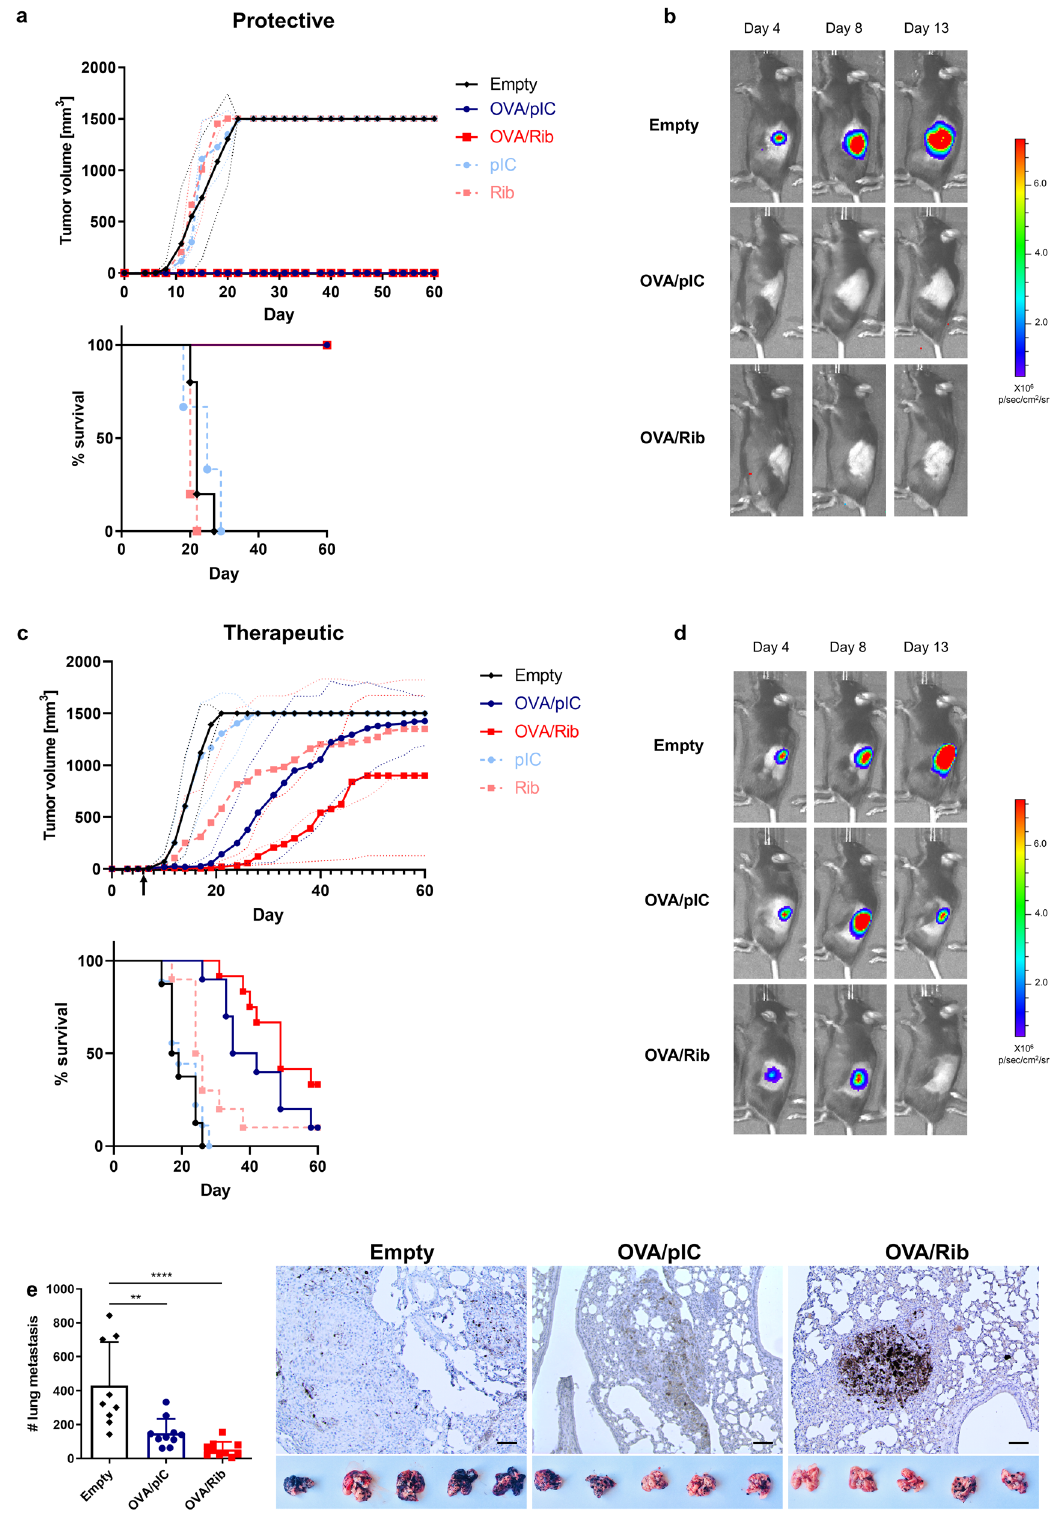
PD-1 together with PLGA microparticles was evaluated against established E.G7 tumors (Supplementary Fig. 11a, b). The combination of anti-PD-1 antibodies with PLGA particle therapy did not result in signi fi cant improvement over therapeutic tumor vaccination with MP-OVA/Riboxxim. However, the addition of a PD-1 inhibitor to the anti-CTLA-4/PLGA-MP-setup supports tumor eradication ef fi cacy and prolongs survival. However, the